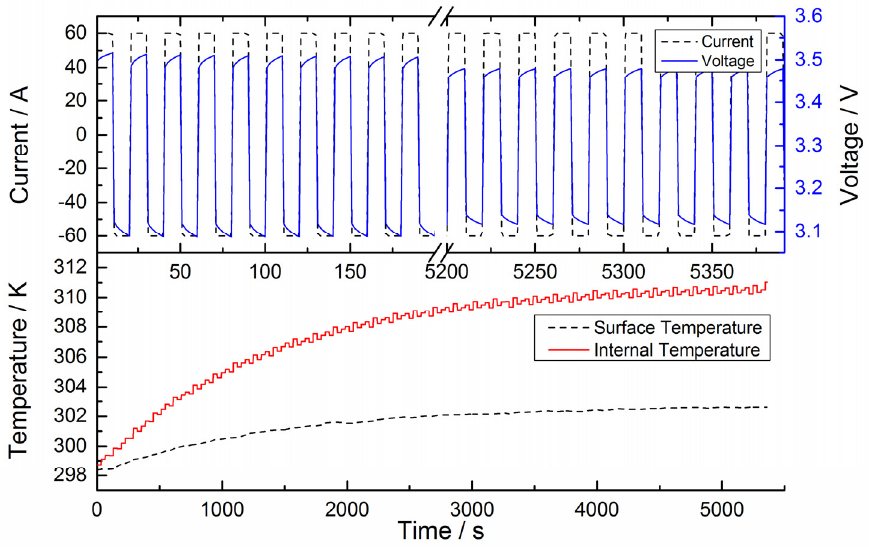
Figure 2. 60 A current pulses test and temperature changes.